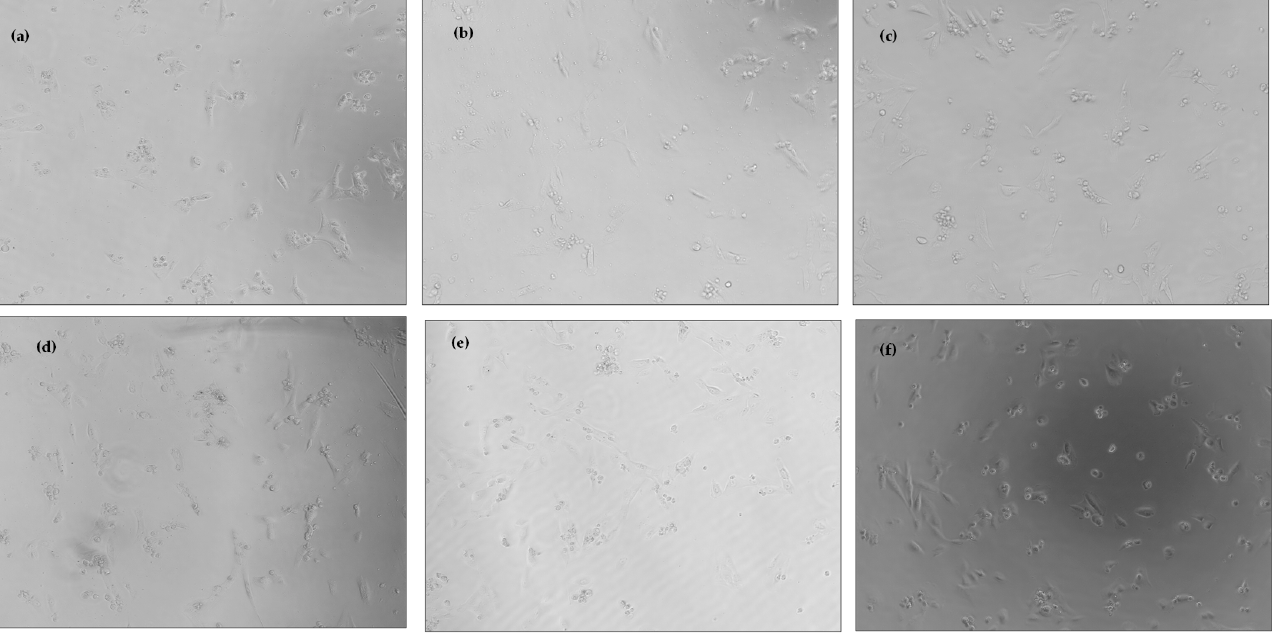
Figure 6. Morphology of HREP cells treated with ( a ) CysA-loaded Span ® transferosomes; ( b ) blank Span ® transferosomes; ( c ) blank Tween ® transferosomes; ( d ) CysA-loaded Tween ® transferosomes; ( e ) ATF; and ( f ) before treatment.